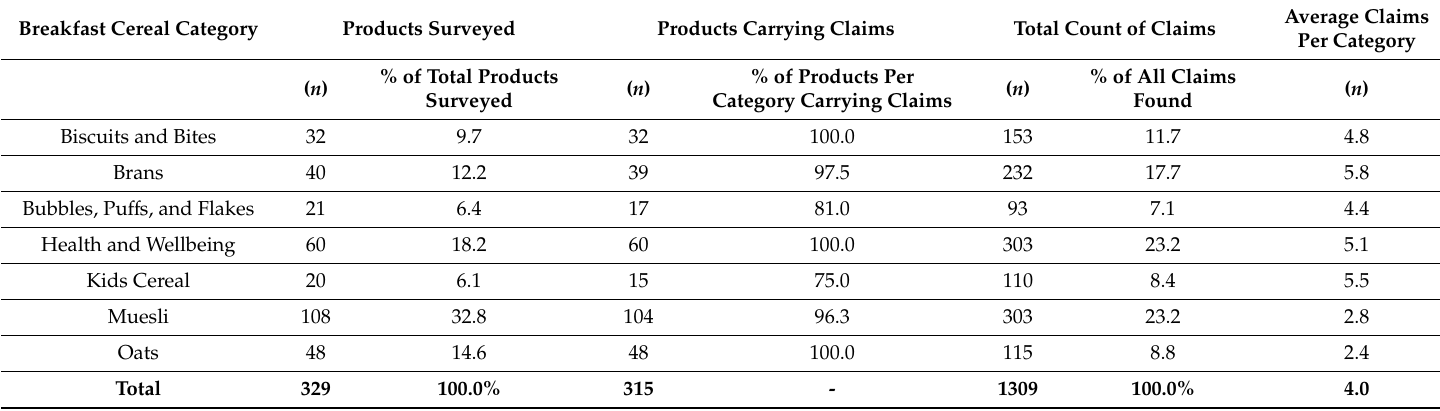
Table 1. Prevalence of nutrition, health and related claims across breakfast cereal categories within the supermarket